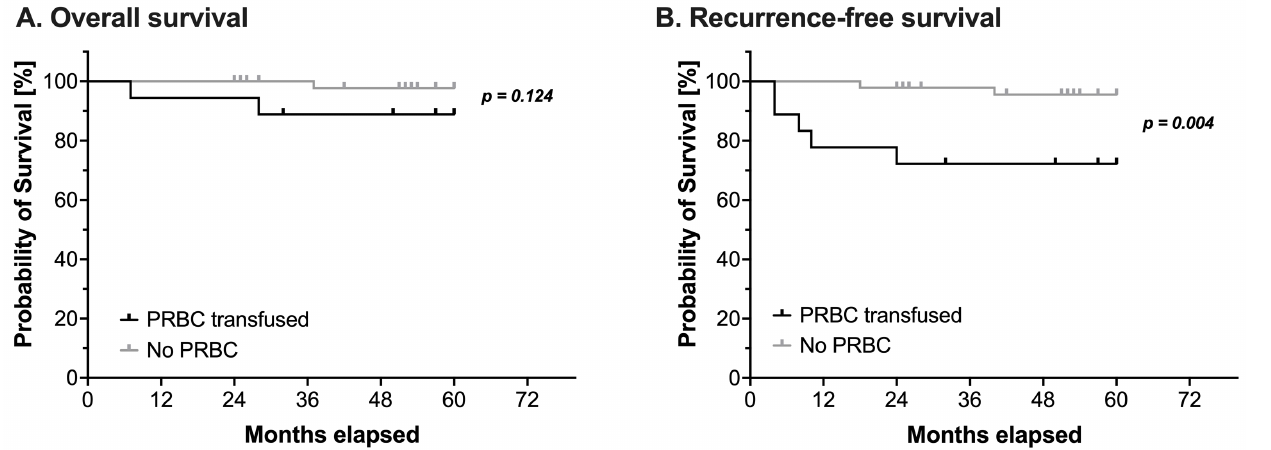
Table 4. Hazard ratios. OS = overall survival; RFS = recurrence-free survival; PRBC = packed red blood cells; RA = regional anesthesia ; TIVA = total intravenous anesthesia; HR = hazard ratio; CI = confidence interval. Statistically significant results are shown in bold numbers.